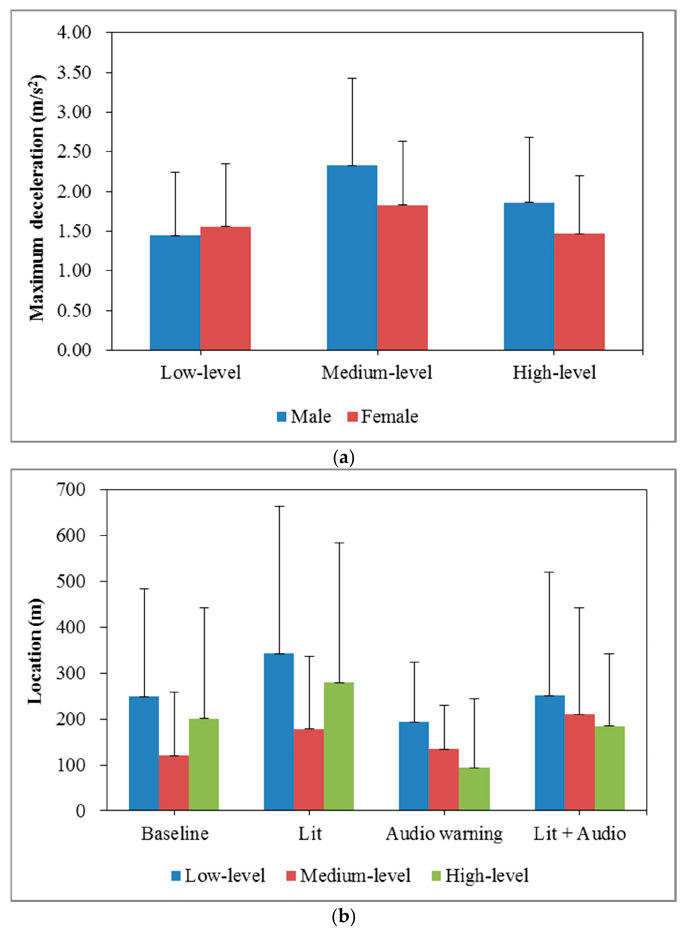
Figure 4. Cont. Figure 4.